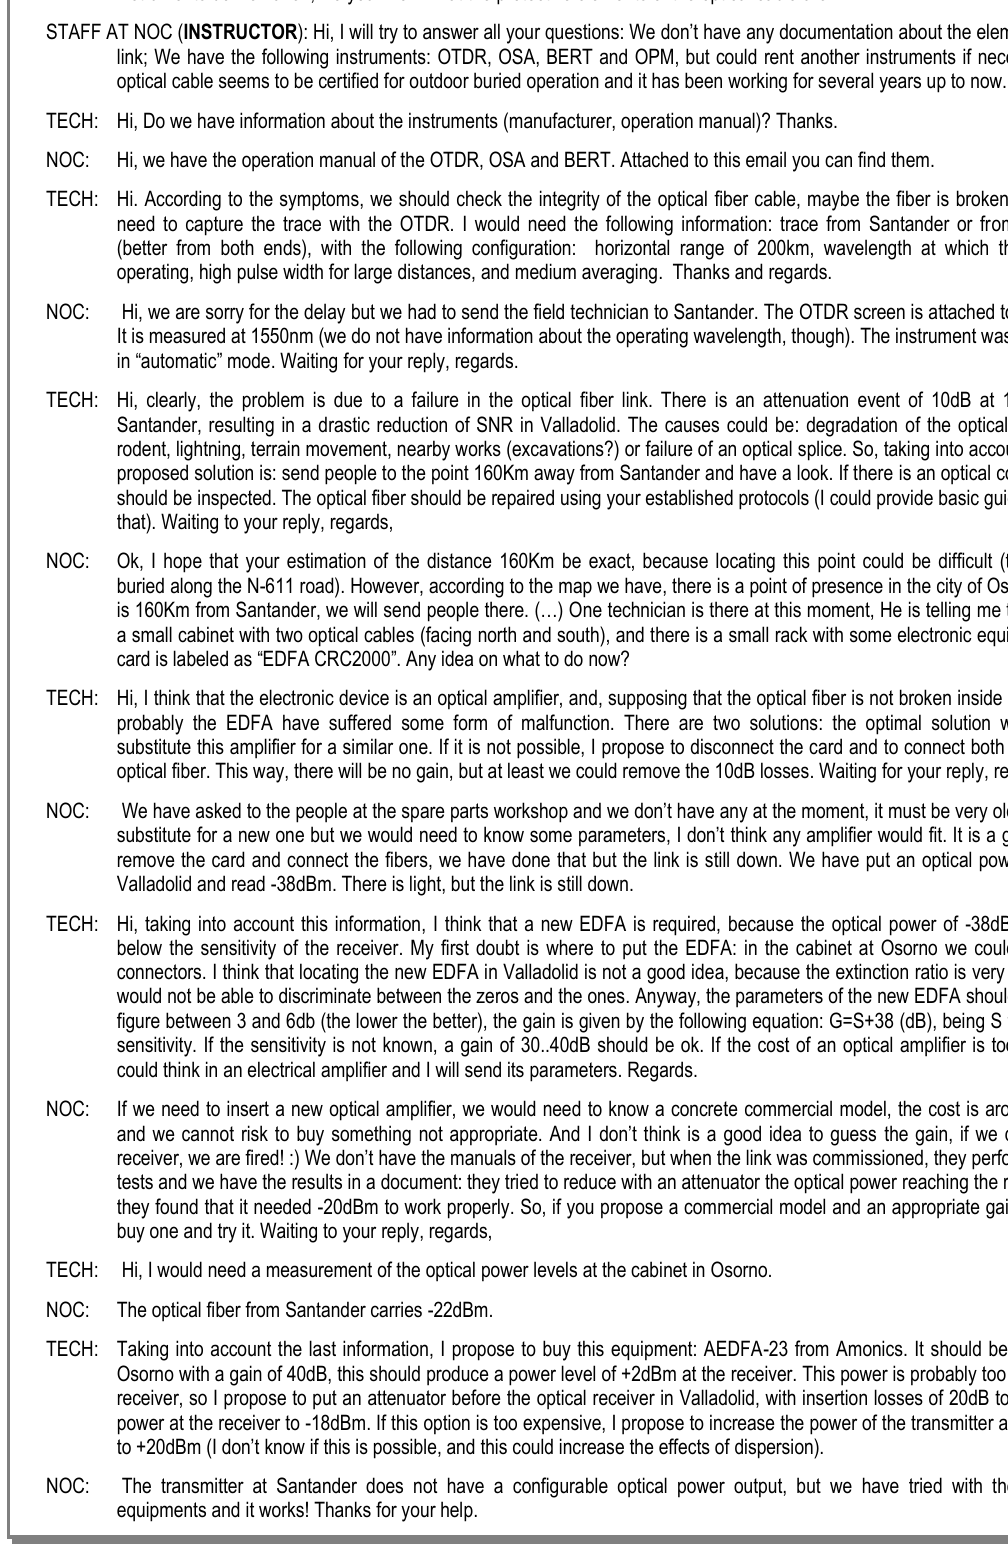
Fig. 4.: Example of one complete conversation between the student (maintenance technician) and the instructor (staff at NOC) regarding the case of a mid-span optical amplifier